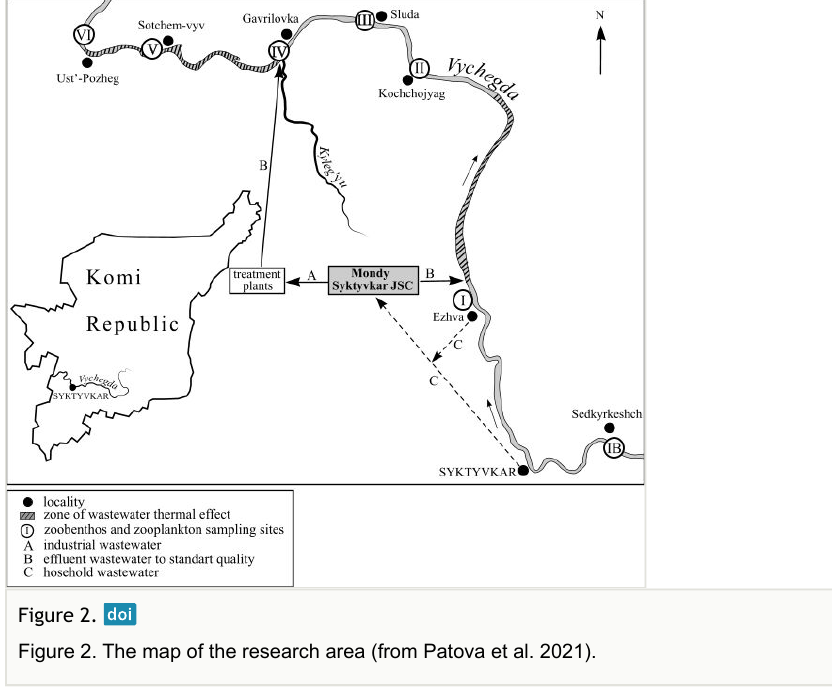
Figure 2. The map of the research area (from Patova et al.